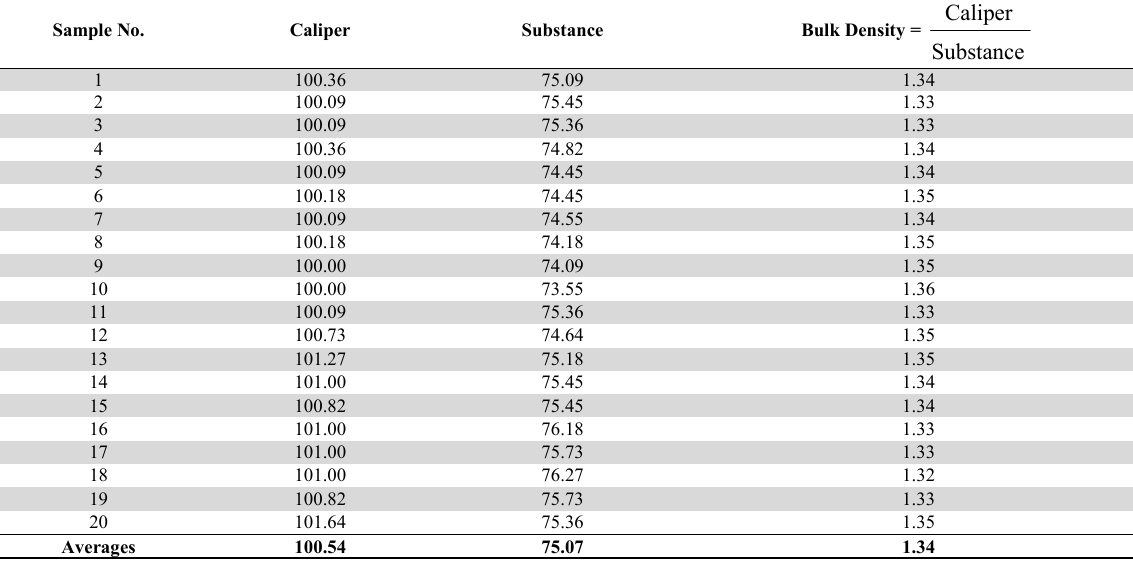
Measurements on bulk density Sample No. Caliper